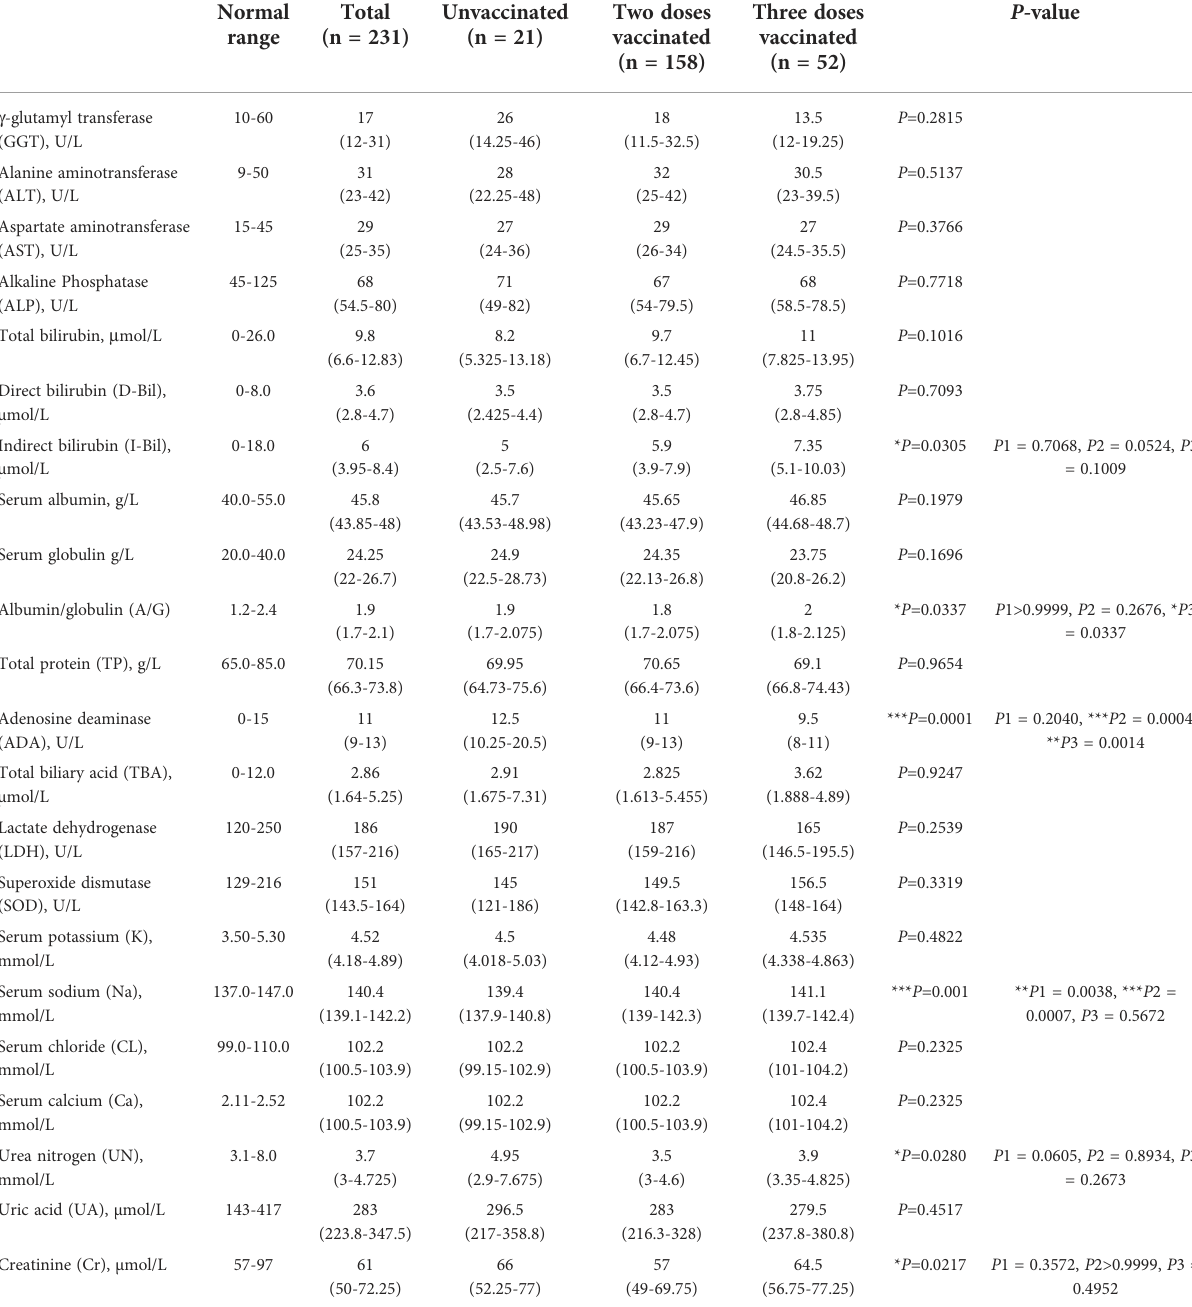
TABLE 4 Blood biochemical pro fi le analysis in patients with COVID-19.